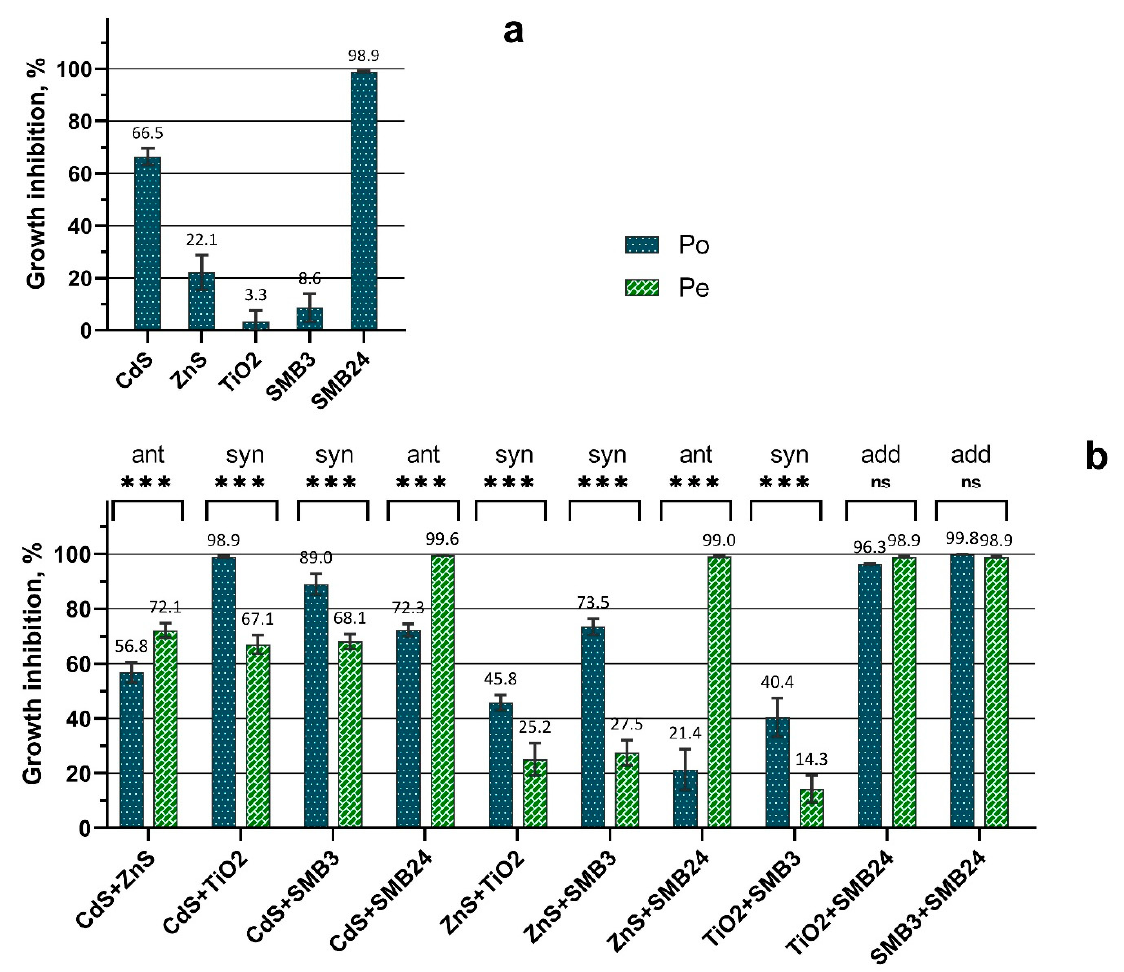
Figure 1. Observed and expected growth inhibition of H. akashiwo exposed to single and binary mixtures of NPs. ( a ) Observed toxicity of single NPs. ( b ) Comparison between the observed and expected toxicity of binary mixtures of NPs. P o = observed toxicity (growth inhibition); P e = expected toxicity (growth inhibition); ant = antagonistic; syn = synergistic; add = additive; *** = p < 0.0001; ns = nonsignificant ( p > 0.05). Growth inhibition was calculated compared with the control, where 0% is no observed effect and 100% is the death of all the cells.